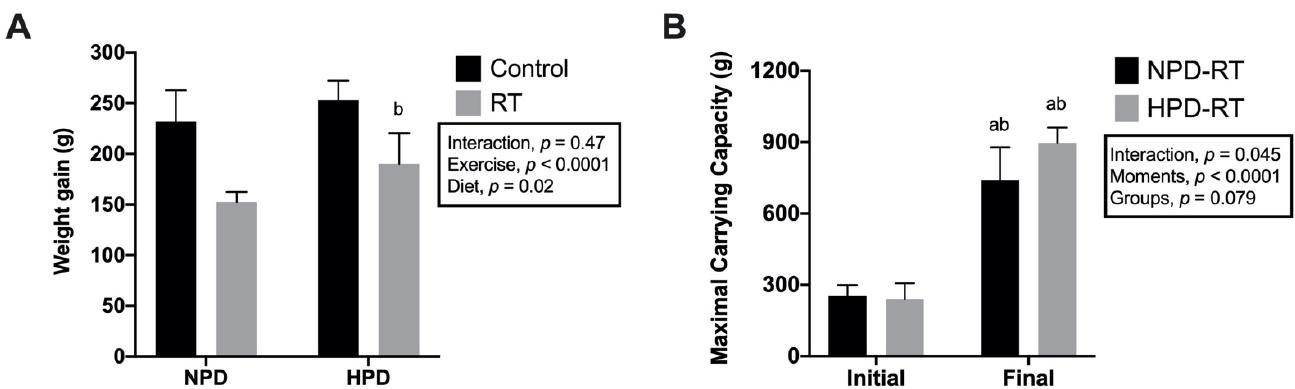
Figure 1. Body weight gain and strength development. ( A ) Body weight gain; ( B ) maximal carrying capacity. Values are presented as means ± SD. a p < 0.05 vs. NPD-Control, b p < 0.05 vs. HPD-Control.